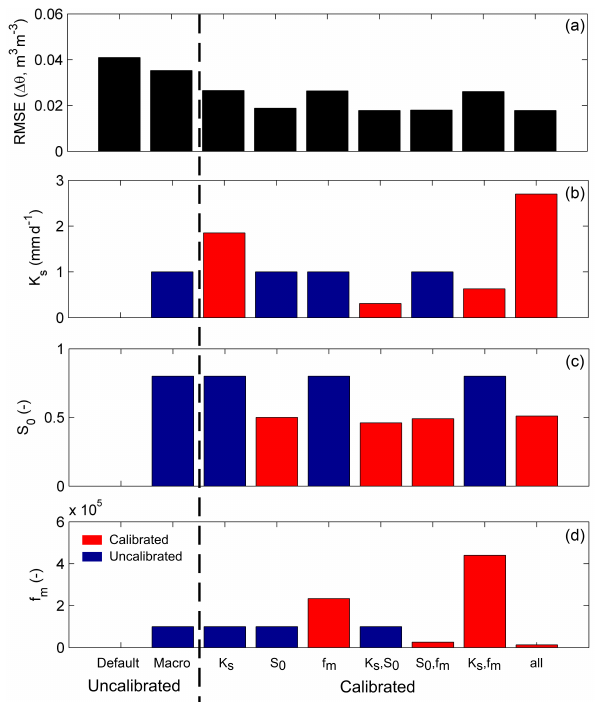
Figure 4. (a) Model performance in reproducing observed and sim- ulated (cid:49)θ , (b) K s , (c) S 0 and (d) f m for the different parameter combinations considered in the optimization. For each parameter (i.e. b , c , and d ), the red bars show cases in which the relevant pa- rameter is calibrated (either individually or in combination with oth- ers), while the blue bars correspond to cases in which the selected parameter is not calibrated (i.e. a fixed value according to the lit- erature as in the macro case). Note that except for the default and macro, the simulation yielding the lowest RMSE (out of 2000 model runs) is presented in this plot.